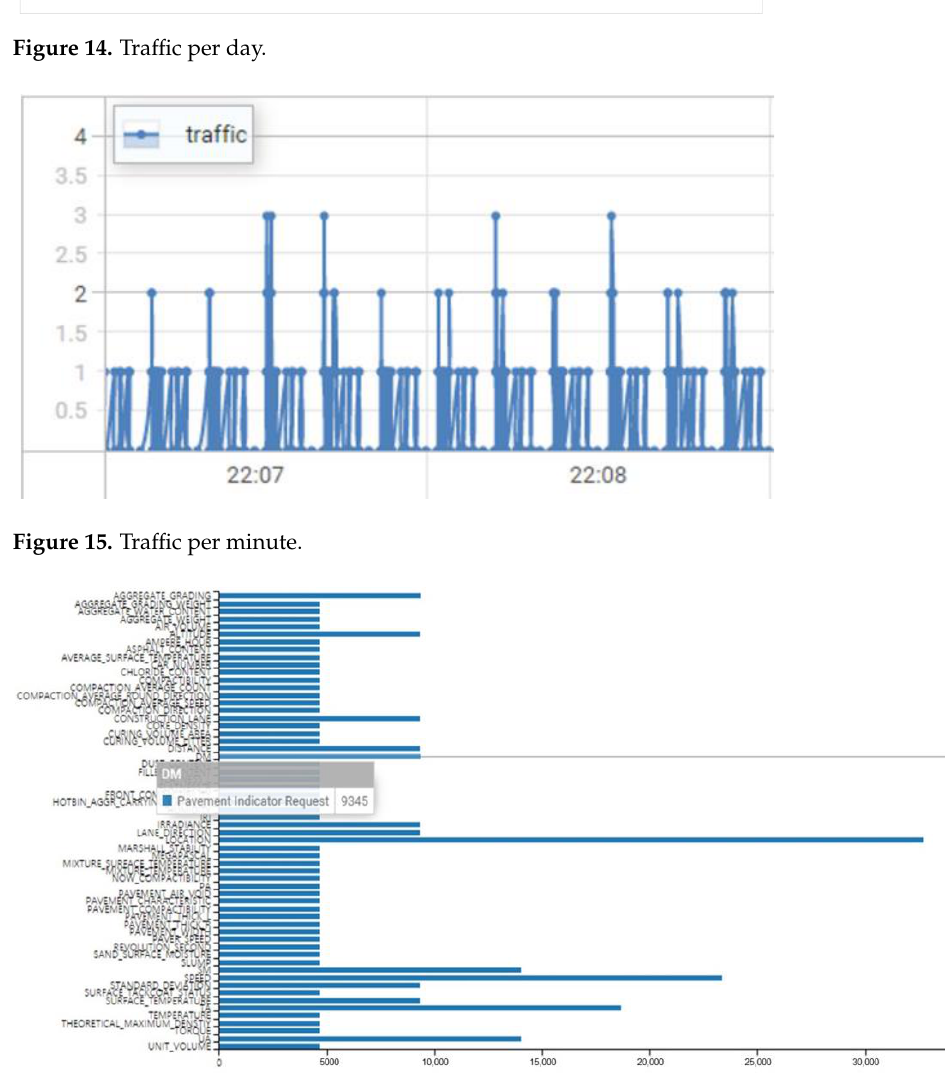
Figure 16. Traffic with respect to pavement quality